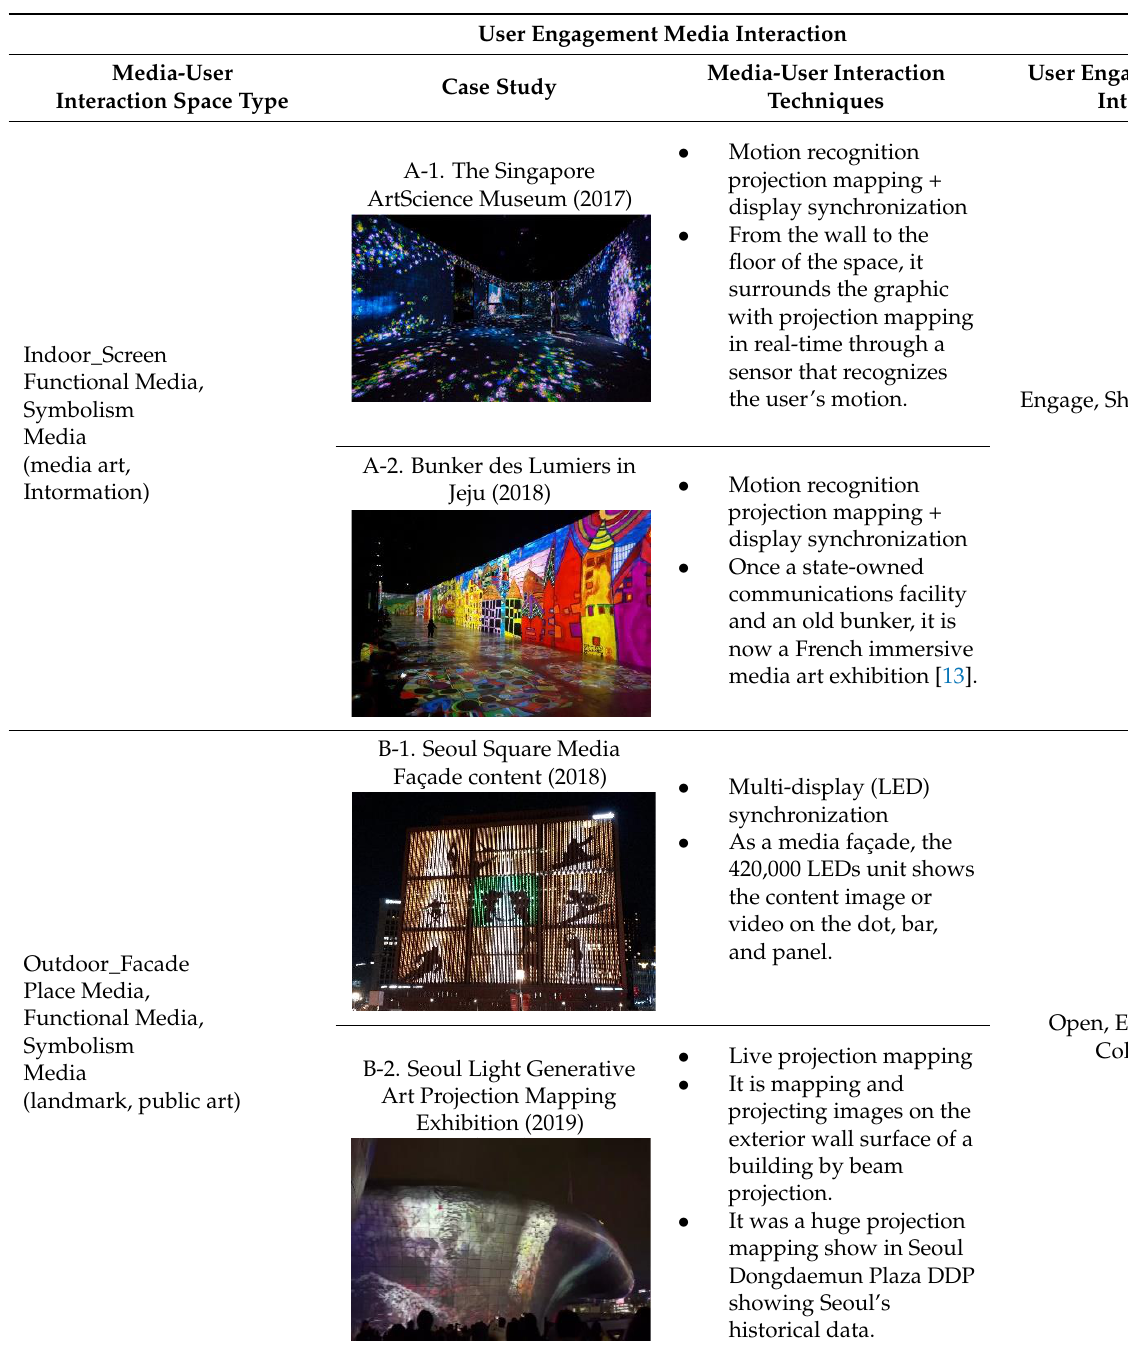
Table 2. Case study by type of media-interaction space: media case analysis in a user participatory public play space.